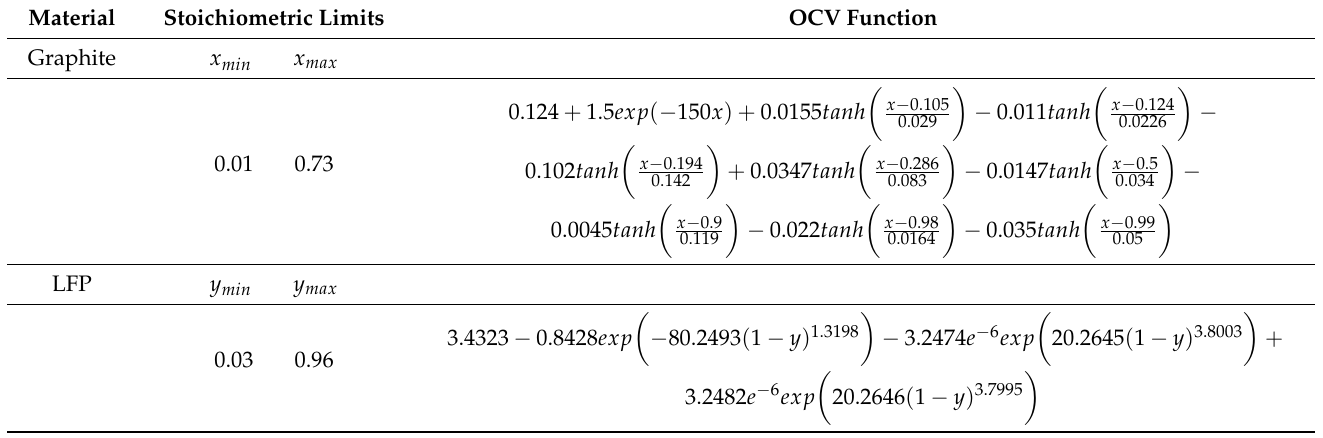
Table 2. Stoichiometric limits which guarantee the best fit between the experimental OCV and the OCV functions of single electrode. OCV function of graphite is by Christensen and Newman [29], and OCV function of LFP is by Safari et al. [30].